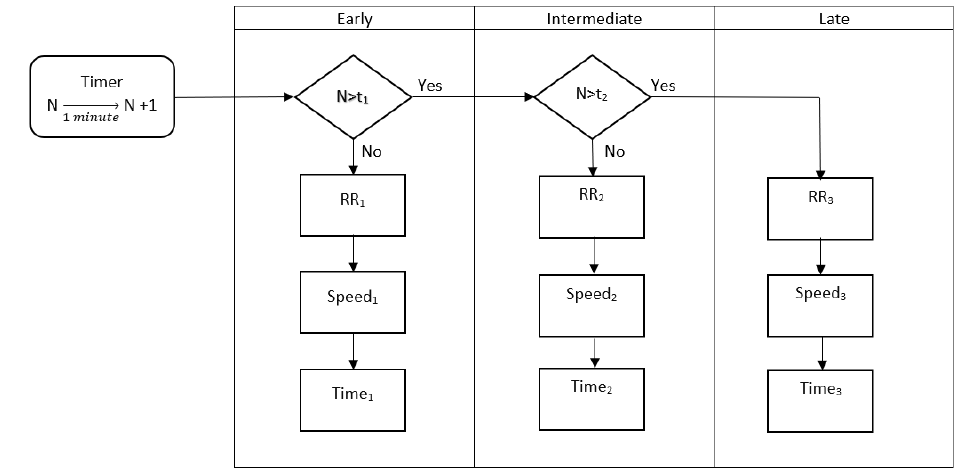
Figure 4. Illustration of the sequence of cases studied for discrete-event simulation.